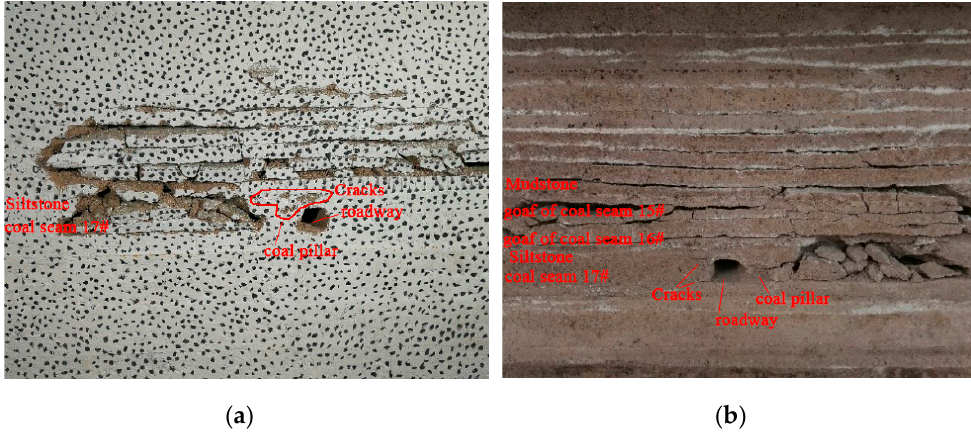
Figure 12. Failure of surrounding rock of roadway under repeated mining: ( a ) Surrounding rock conditions of the roadway in front of the model; ( b ) Surrounding rock conditions of the roadway behind the model.